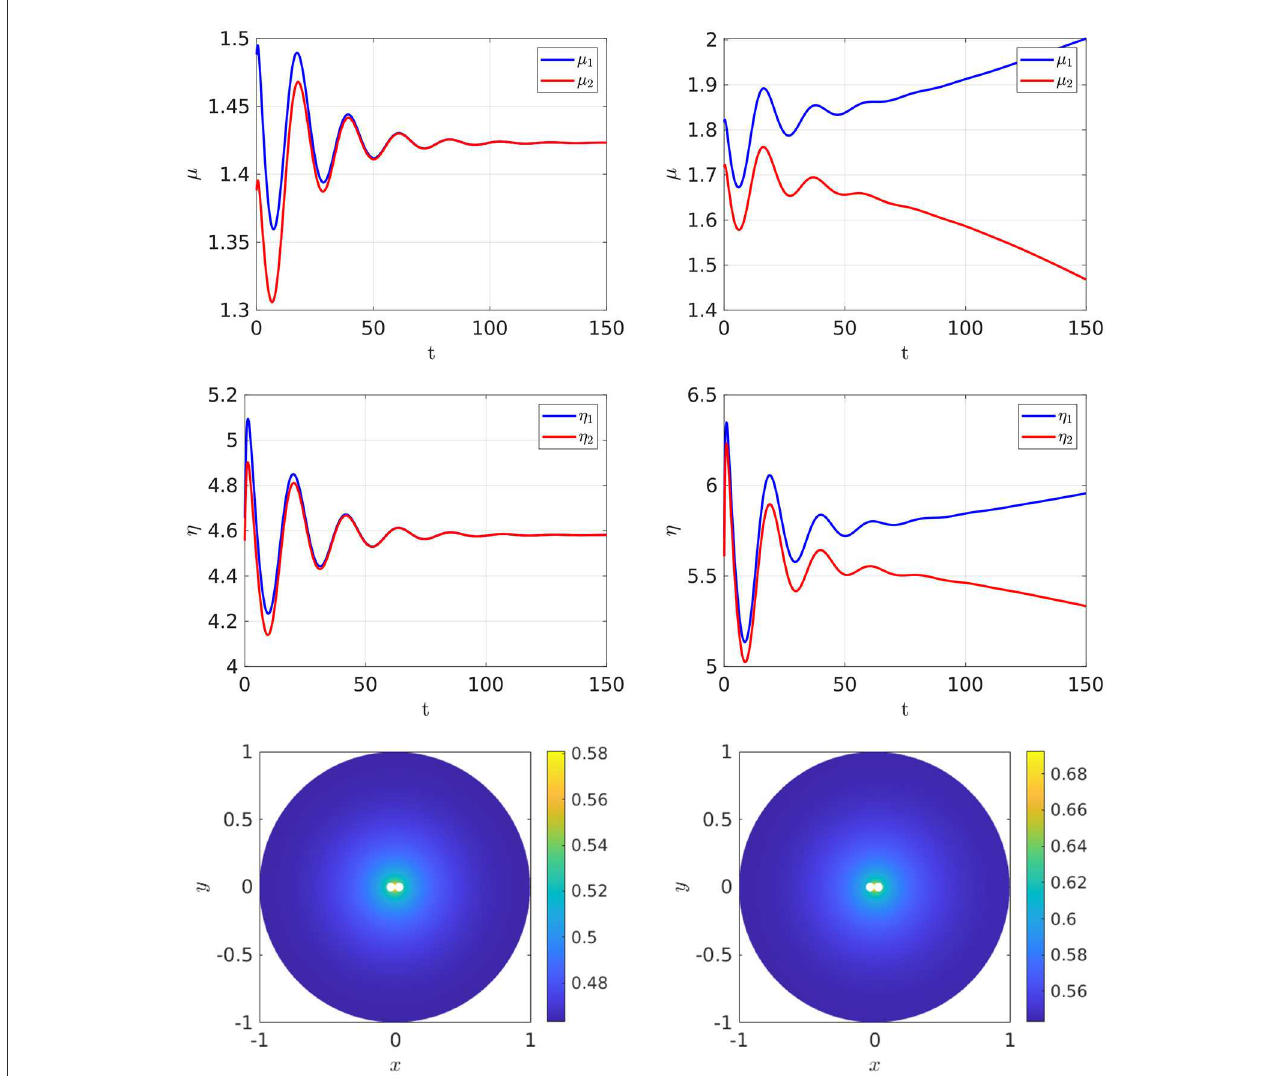
FIGURE17 Full numerical simulation results of Equation (2.3) with FlexPDE [50] for GM kinetics (Equation 4.3) with two closely spaced cells centered on a ring of radius r 0.031 and with minimum cell separation of 0.002. The other parameters are the same as in Table 3. The only difference here is that the cells are = now much more closely spaced. The bottom two panels show the concentration of u . Left: convergence to a stable symmetric steady-state solution when ρ 3. Right: convergence to a stable asymmetric steady-state soluton for ρ = D u 5, D v 1.5, σ u 0.6, d u 0.08, and ε σ v = = = = = =